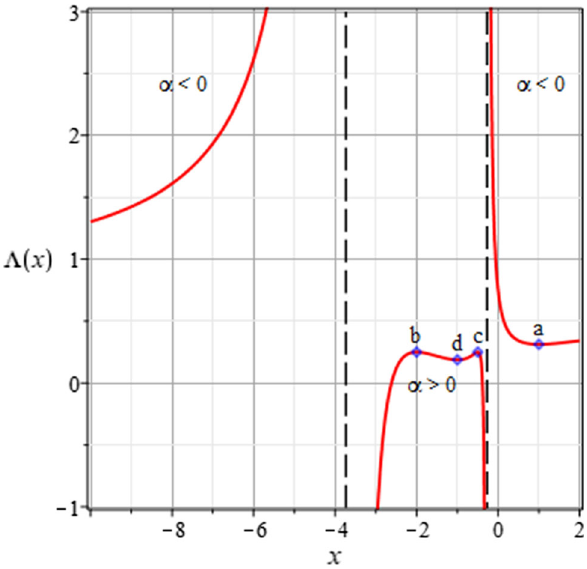
Fig. 3 The function λ( x ) = (cid:2)( x )α for α > 0, l = 12